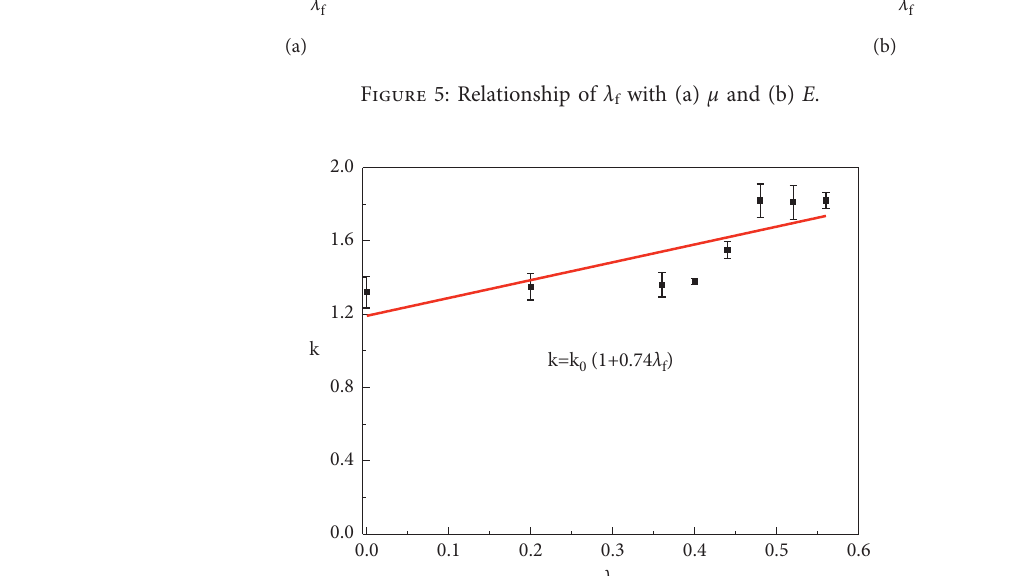
Figure 6: Relationship of k with λ